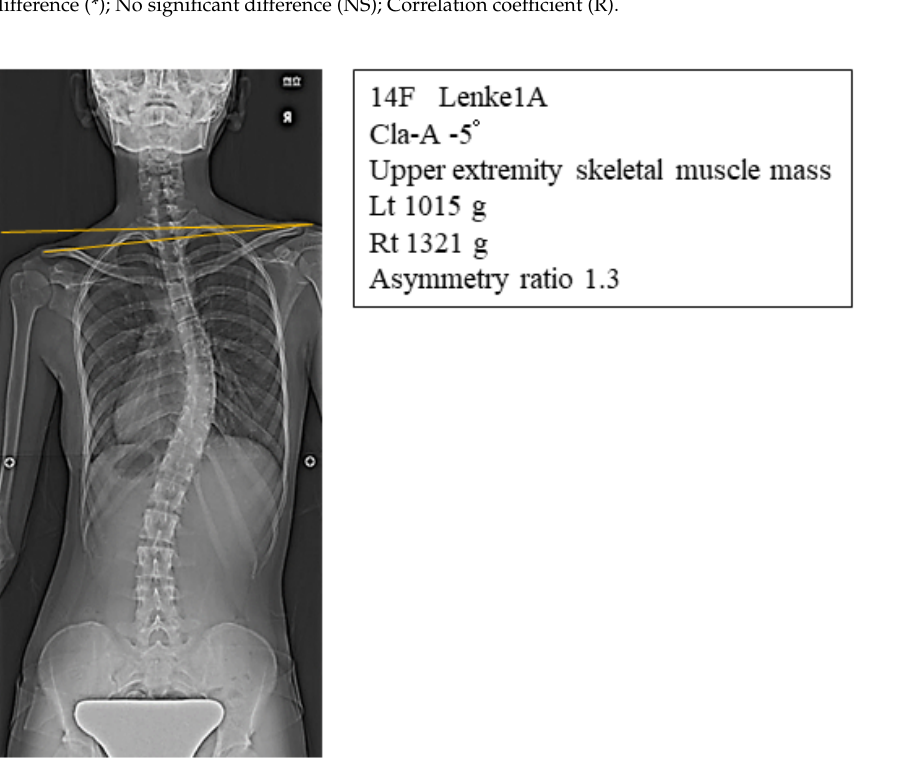
Figure 4. Representative radiograph of a Lenke 1A AIS patient with a right shoulder imbalance who had a large asymmetry ratio of upper arm skeletal muscle mass.